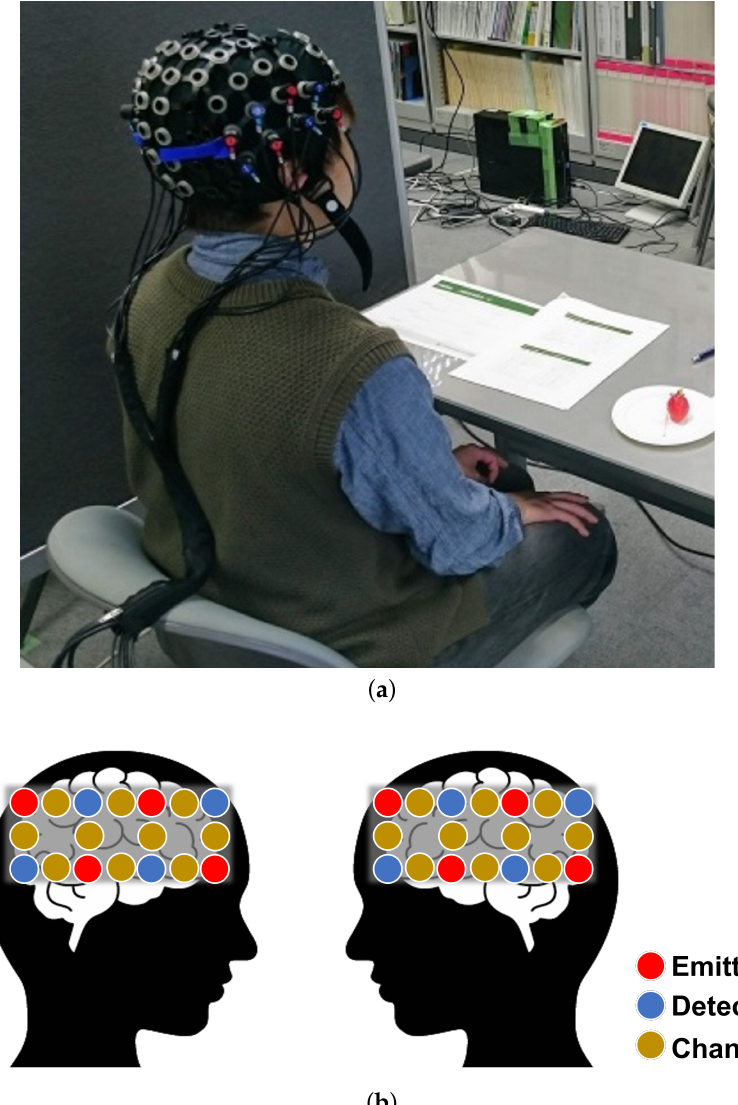
Figure 4. Photographic example and positions of channels. General fNIRS systems consist of (i) an emitter to illuminate a small area of tissue with light at two or more wavelengths (red and infrared range), and (ii) the detector to measure the back-scattered light emerging from the tissue. The midpoint between the emitter and detector was assumed to be the location where the change in the oxygenated and deoxygenated hemoglobin was measured; this is called the channel. ( a ) A photographic example of fNIRS data acquisition. ( b ) Positions of